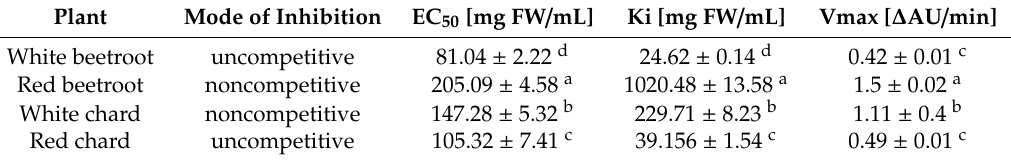
Table 3. EC 50 value, Ki value, Vmax value, and mode of xanthine oxidase inhibition by extracts from leaves of white beetroot (SK), beetroot (CC), white chard (BL), and red chard (LC) ( n = 9).